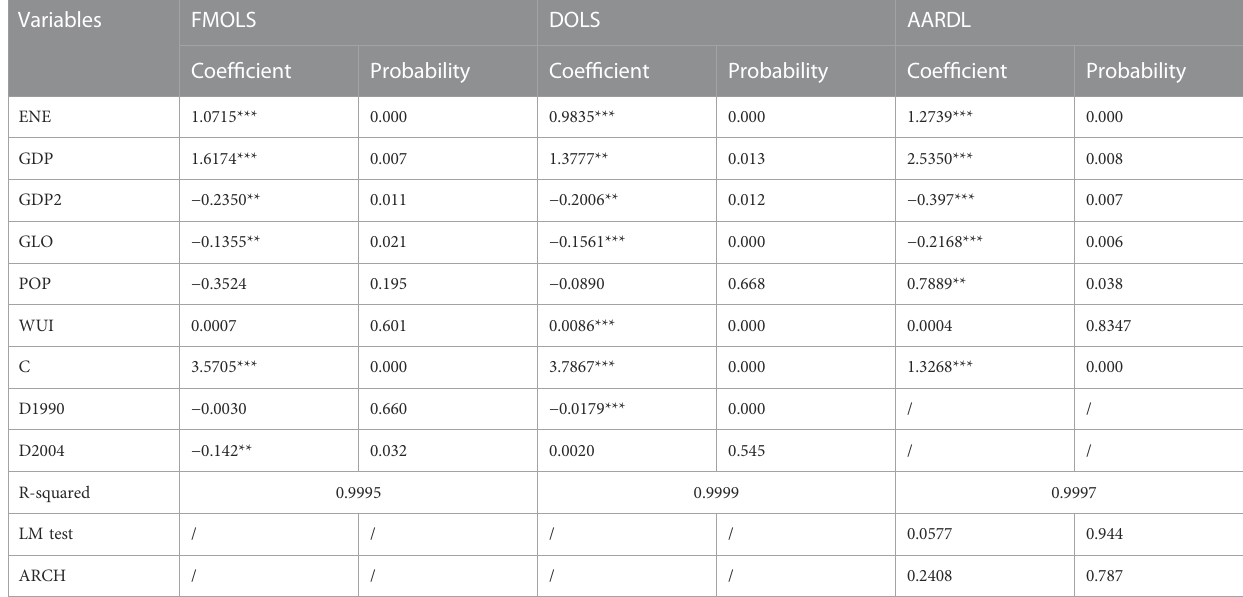
TABLE 3 Long run estimation results.